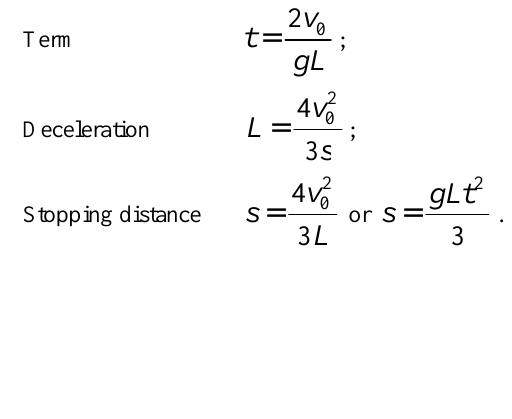
Fig 9. Rate of deceleration with a triangular form (No